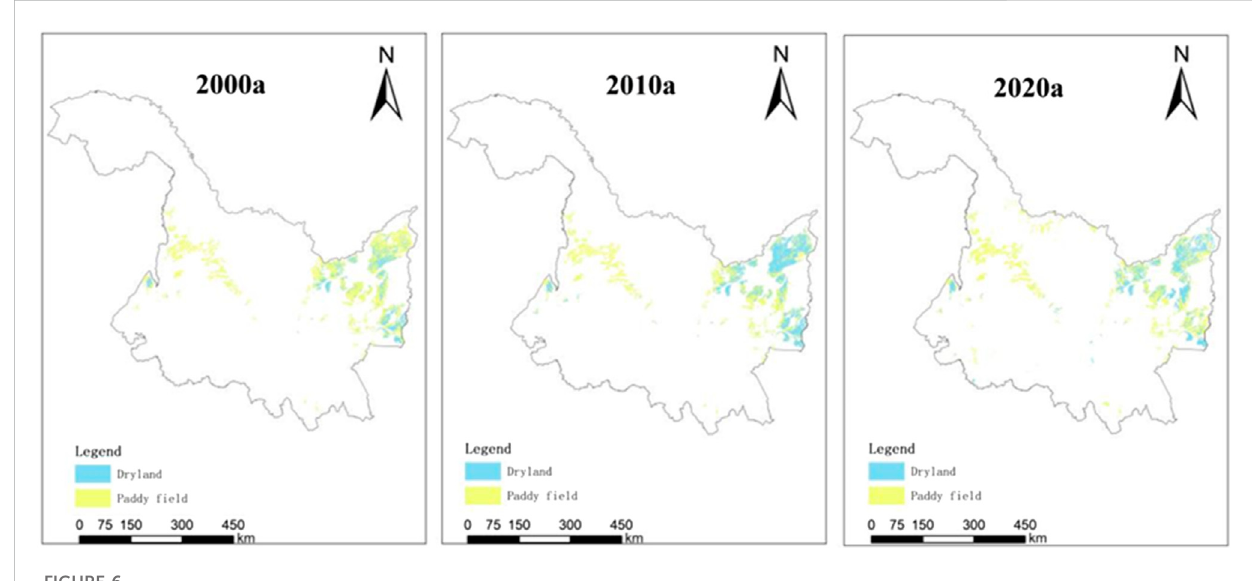
FIGURE 6 2000 – 2020a Distribution of paddy and dryland in